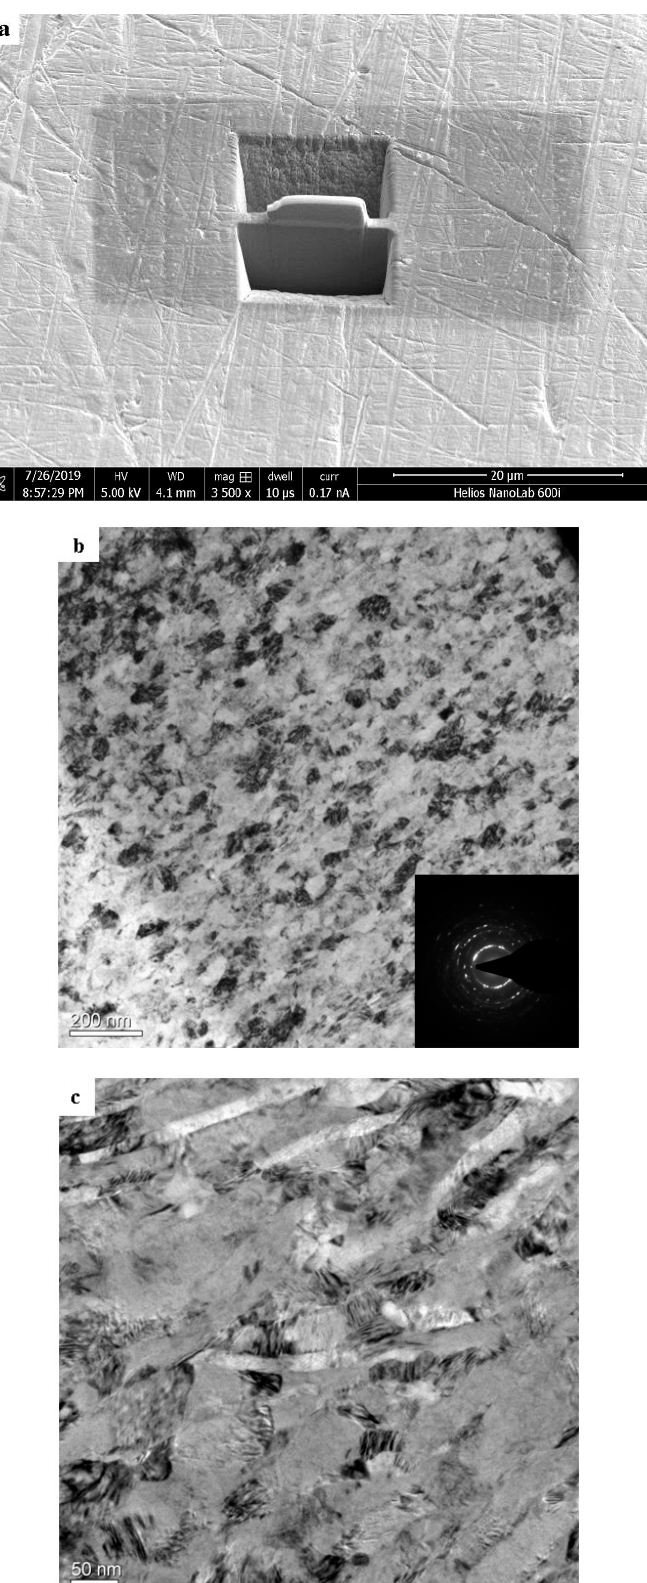
Figure 2. TEM observation of TLM with ultrasonic surface impact: ( a ) TEM sample prepared by FIB; ( b ) image and diffraction pattern; ( c ) dislocation walls.